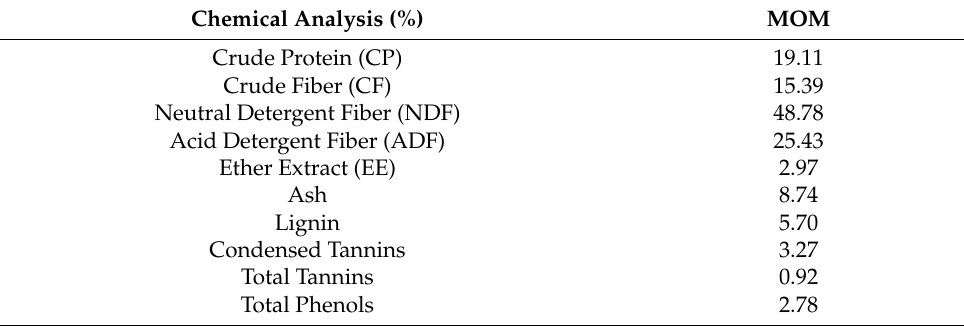
Table 1. Chemical analysis of MOM (dry matter basis).